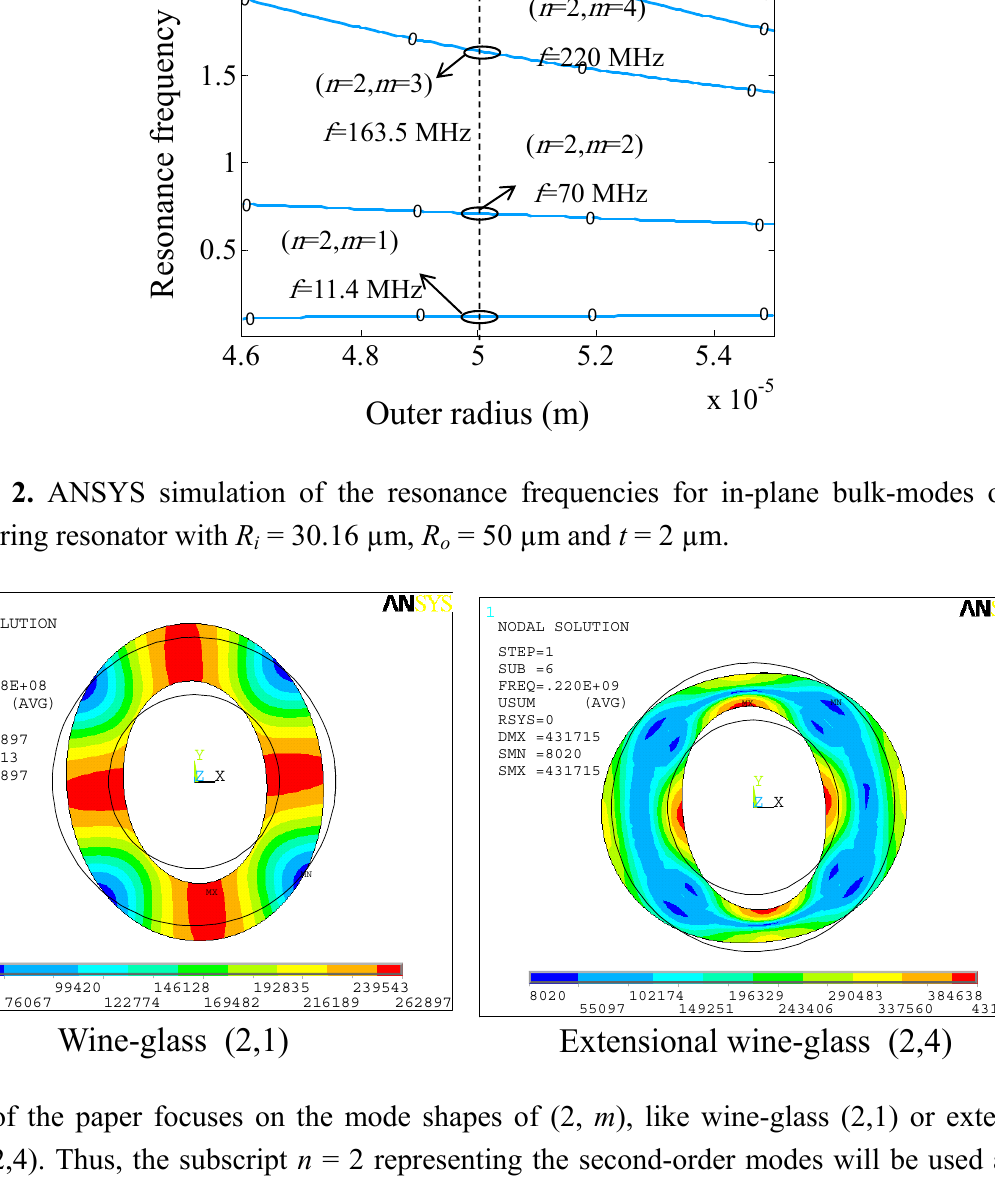
Figure 1. Numerical calculation of mechanical resonance frequency for second-order modes (2, m ) in silicon ring resonator with R